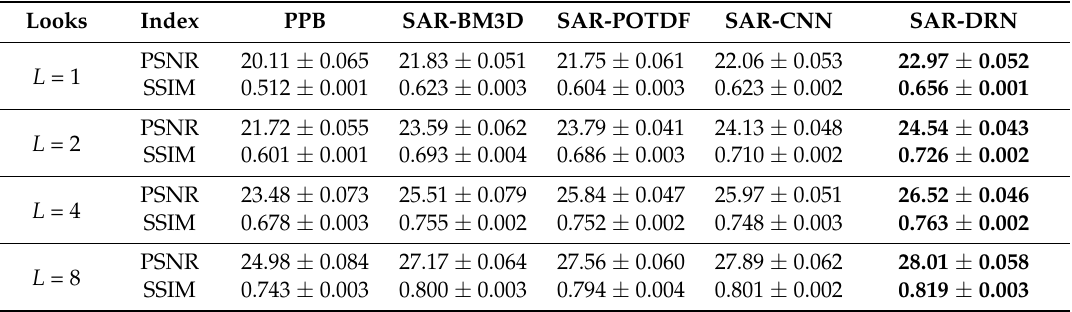
Table 2. Mean and Stand Deviation Results of PSNR (dB) and SSIM for Airplane with L = 1, 2, 4, and 8.